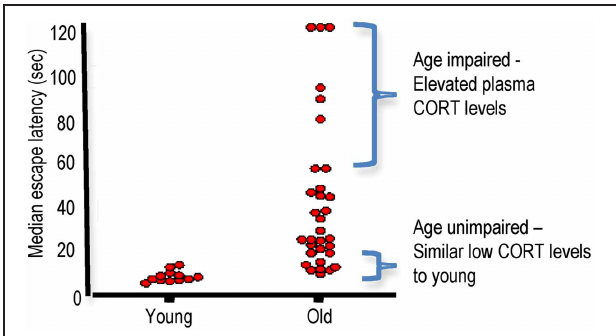
FIGURE 3 | Aged Lister hooded rats show inter-individual differences in spatial learning in the watermaze. 24 months old male Lister hooded rats show impaired spatial learning and memory in the watermaze as a group compared to 6 months old controls. However, individual performances taking the median of the escape latencies (4 trials/day) for the last 2 days of training shows a large spread of learning abilities for aged rats. Plasma corticosterone (CORT) levels in the aged rats correlated negatively with spatial memory with impaired aged rats showing increased CORT while unimpaired aged rats had lower CORT similar to young controls (Based on Yau et al., 1995, with permission from Elsevier).